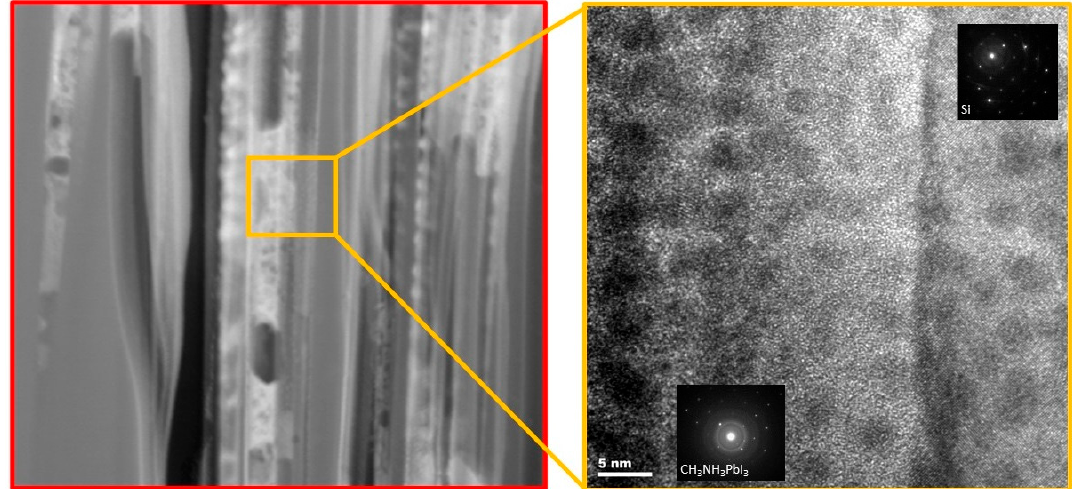
Figure 9. TEM image of silicon wafer with wires etched by MAE for 5 min with the perovskite layer obtained in a two-step deposition process. The left image is a representation of the red square in Figure 8, the right image is a high resolution image of a transition zone.